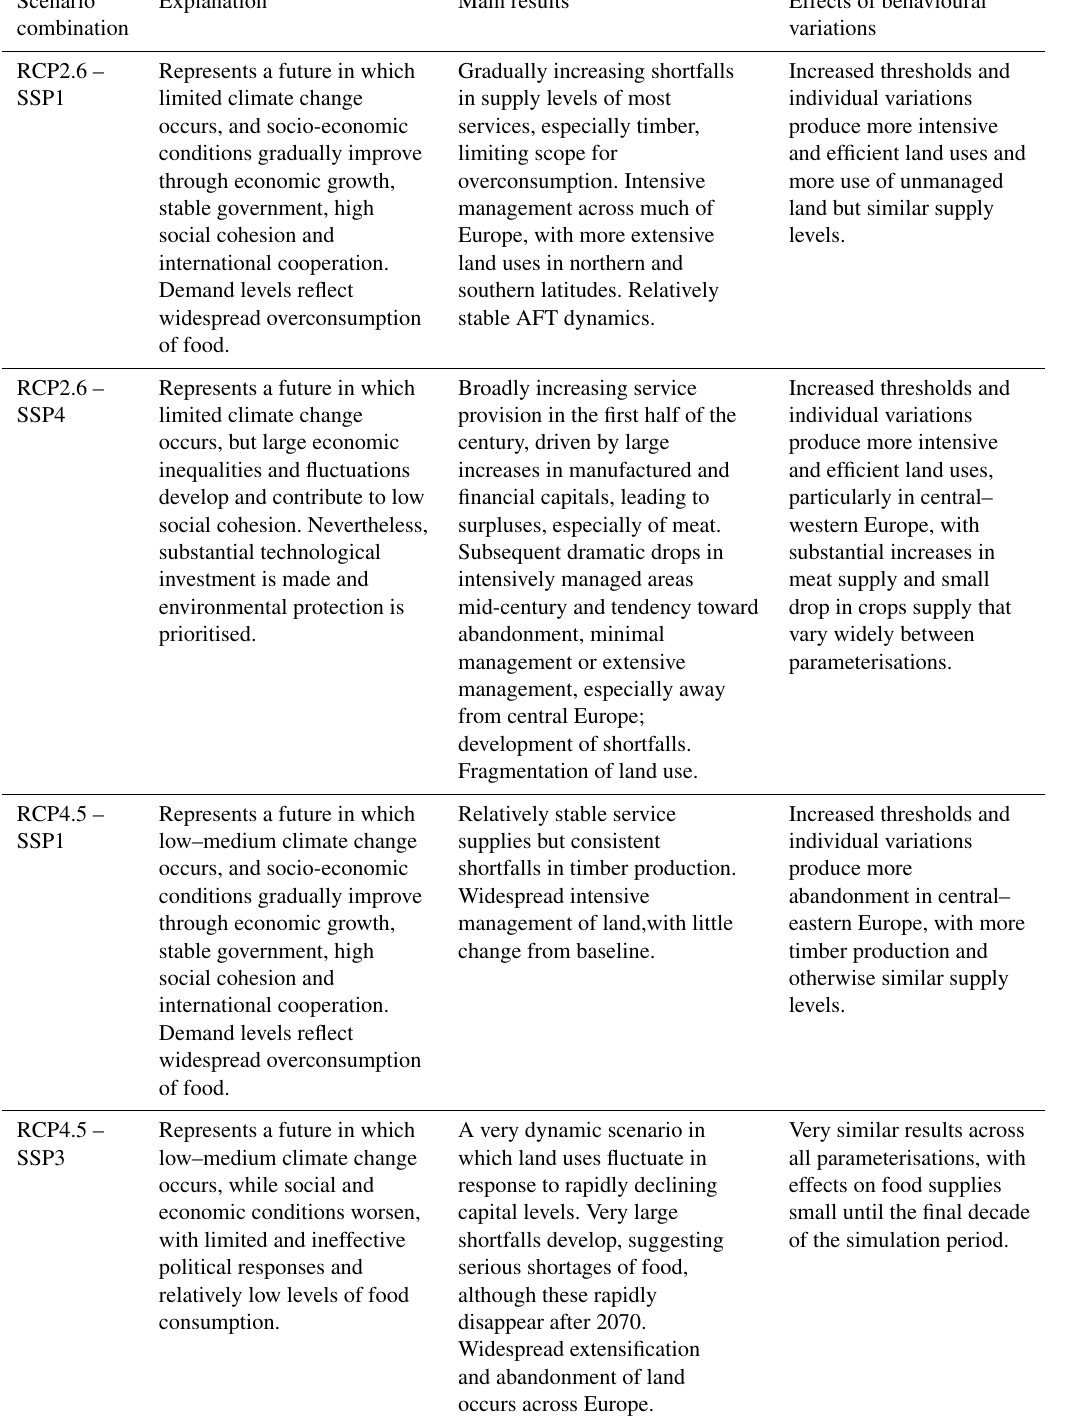
Table 2. Identities and characteristics of Representative Concentration Pathway–Shared Socioeconomic Pathway combinations used in the CRAFTY-EU simulations presented here. Graphical results are shown in Supplement 2, and full descriptions of the scenarios used can be found in Kok et al.